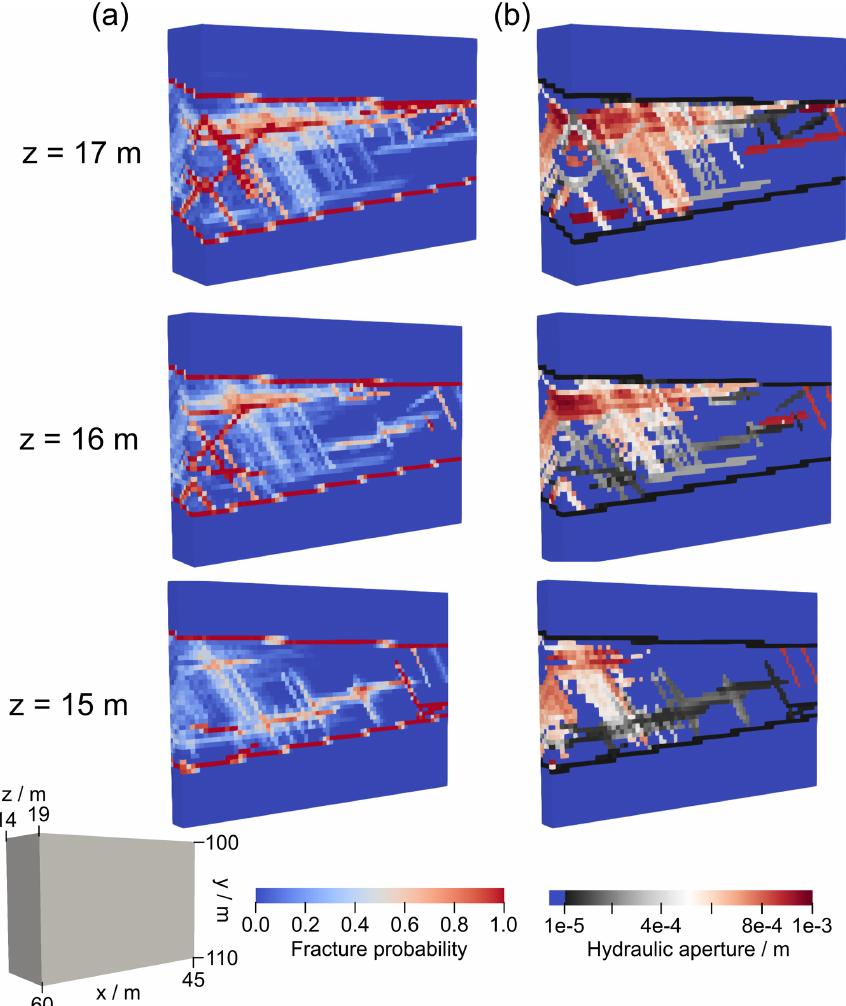
Figure 6. Evaluation of the results from the fracture probability map (a) and the mean hydraulic aperture (b) for different cross sections ( z ). The boundaries of the investigated volume are indicated by the cuboid in the lower